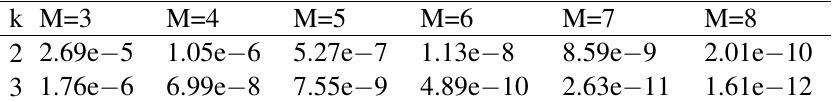
Table 5 L ∞ error under different